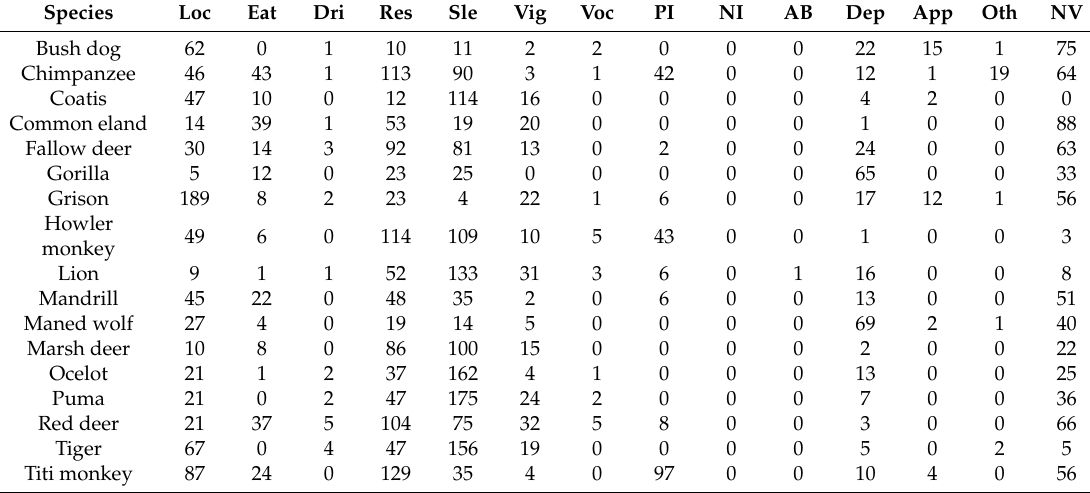
Table 3. Behaviours registers by species during a study into the visitor effect on mammals at the Belo Horizonte Zoo, Minas Gerais, Brazil (Behaviours initials according to Table